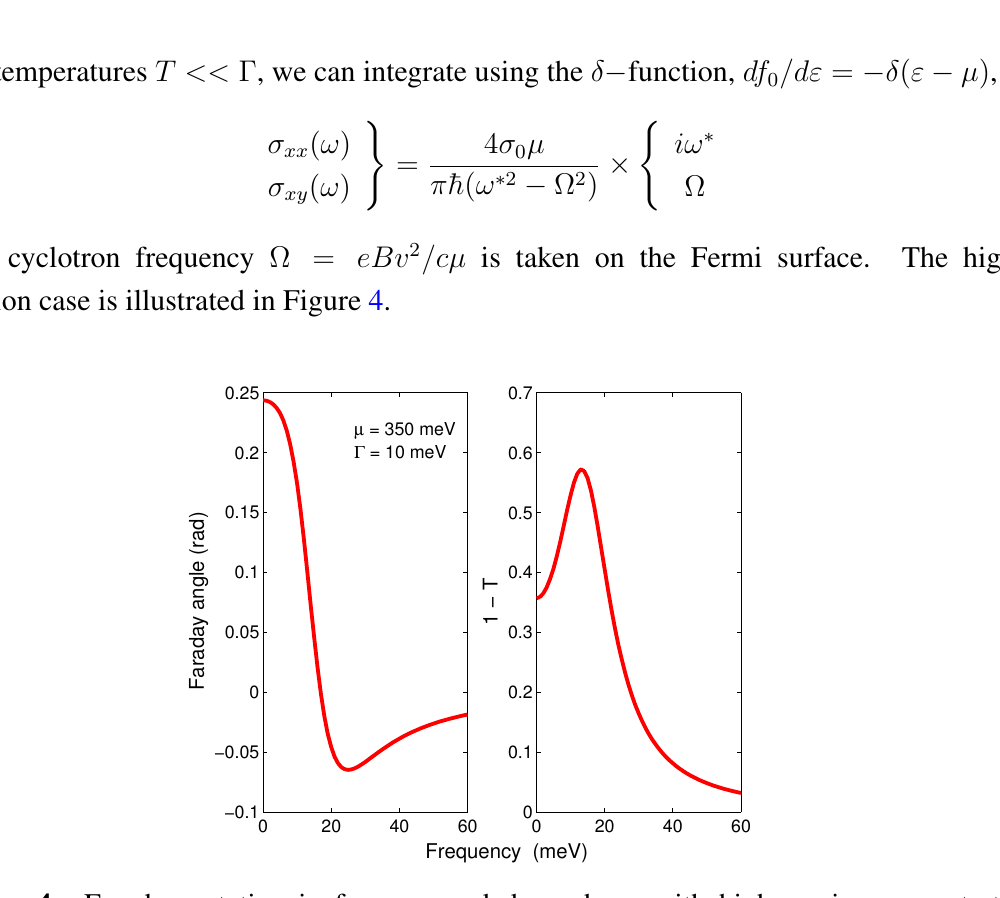
Figure 4. Faraday rotation in free suspended graphene with high carrier concentration at a magnetic field 7 T; 13 levels in the upper electron band are below the Fermi level; the cyclotron frequency at the Fermi level Ω = 13 meV; the electron relaxation frequency Γ = 10